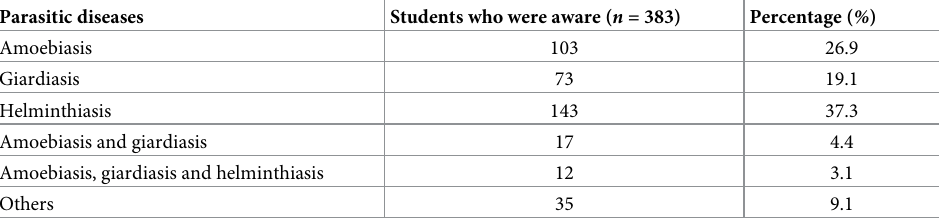
Table 3. Awareness of intestinal parasitic diseases among Grade 4–8 primary school students in Dessie City, Ethi- opia, April to June 2018. Parasitic